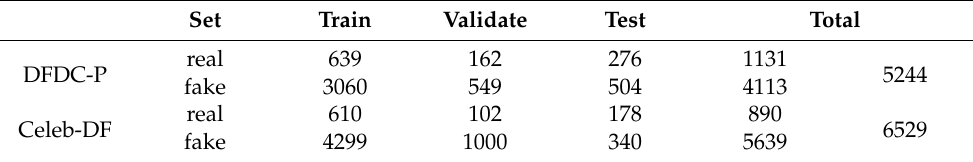
Table 2. Datasets’ distribution among the three training, validation and